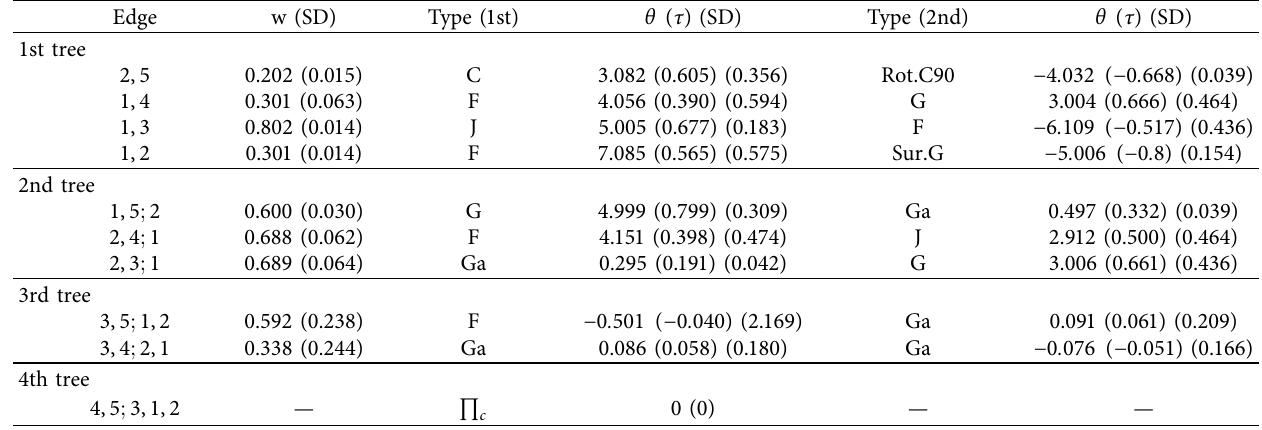
Table 5: Summary of 3-levels truncated R -vine copula mixture model.